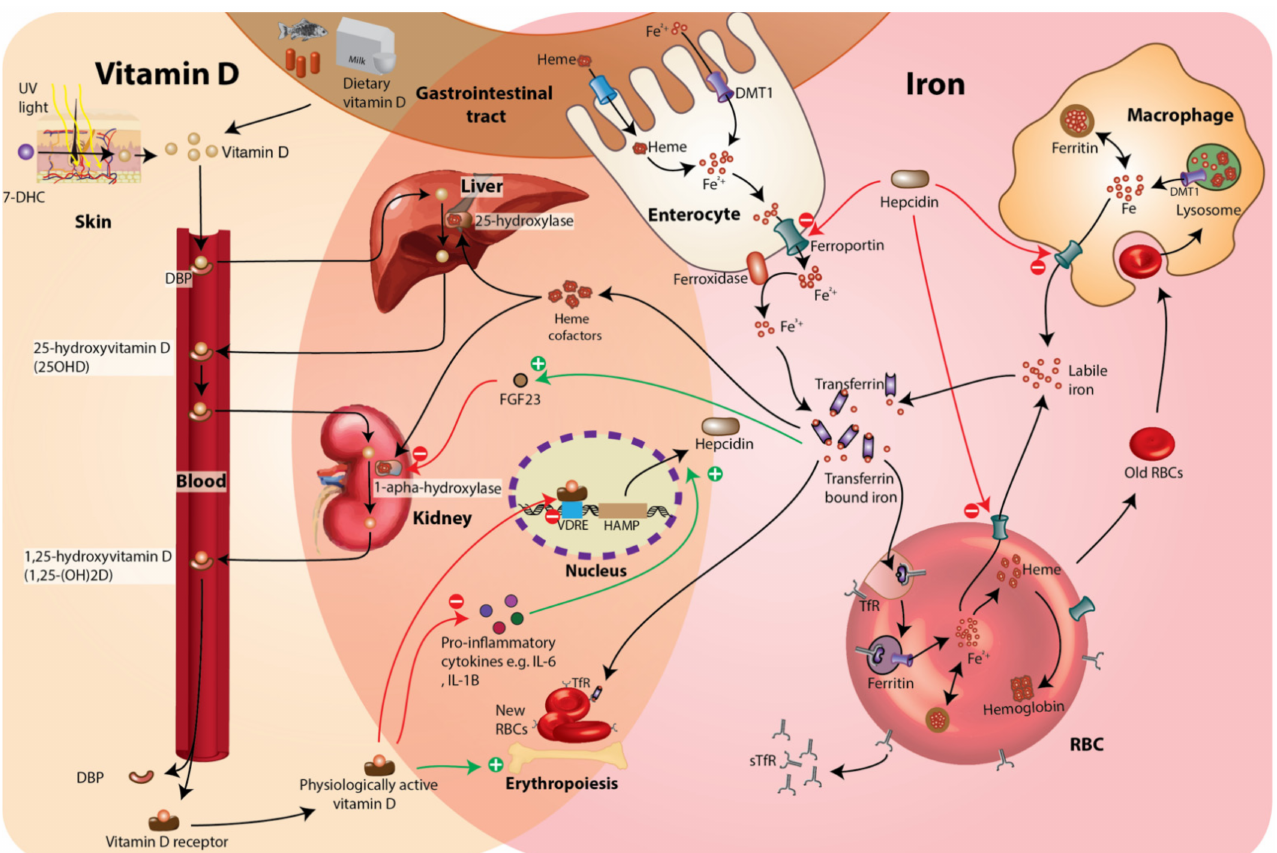
Figure 1. How the metabolism of vitamin D and iron is interlinked from in vitro and animal studies. 1,25(OH) 2 D may influence iron status by reducing hepcidin levels through directly binding to the vitamin D response element (VDRE) in the promoter region of the hepcidin gene ( HAMP ), decreasing pro-inflammatory cytokines (e.g., IL6, IL1B) and support erythropoiesis [5,6,13,14]. Low iron status may also influence vitamin D status by decreasing the activity of vitamin D activation enzymes (25- and 1 α -hydroxylase) [7] and increasing FGF23 [8]. High levels of FGF23 suppress 1 α -hydroxylase activity thus reducing 1,25(OH) 2 D concentrations [9,15]. Abbreviations: sTfR, soluble transferrin receptor; DMT1, divalent metal transporter 1; DBP vitamin D binding protein; Cp, ceruloplasmin; FGF23, fibroblast growth factor 23; RBC, red blood cell; 7-DHC,